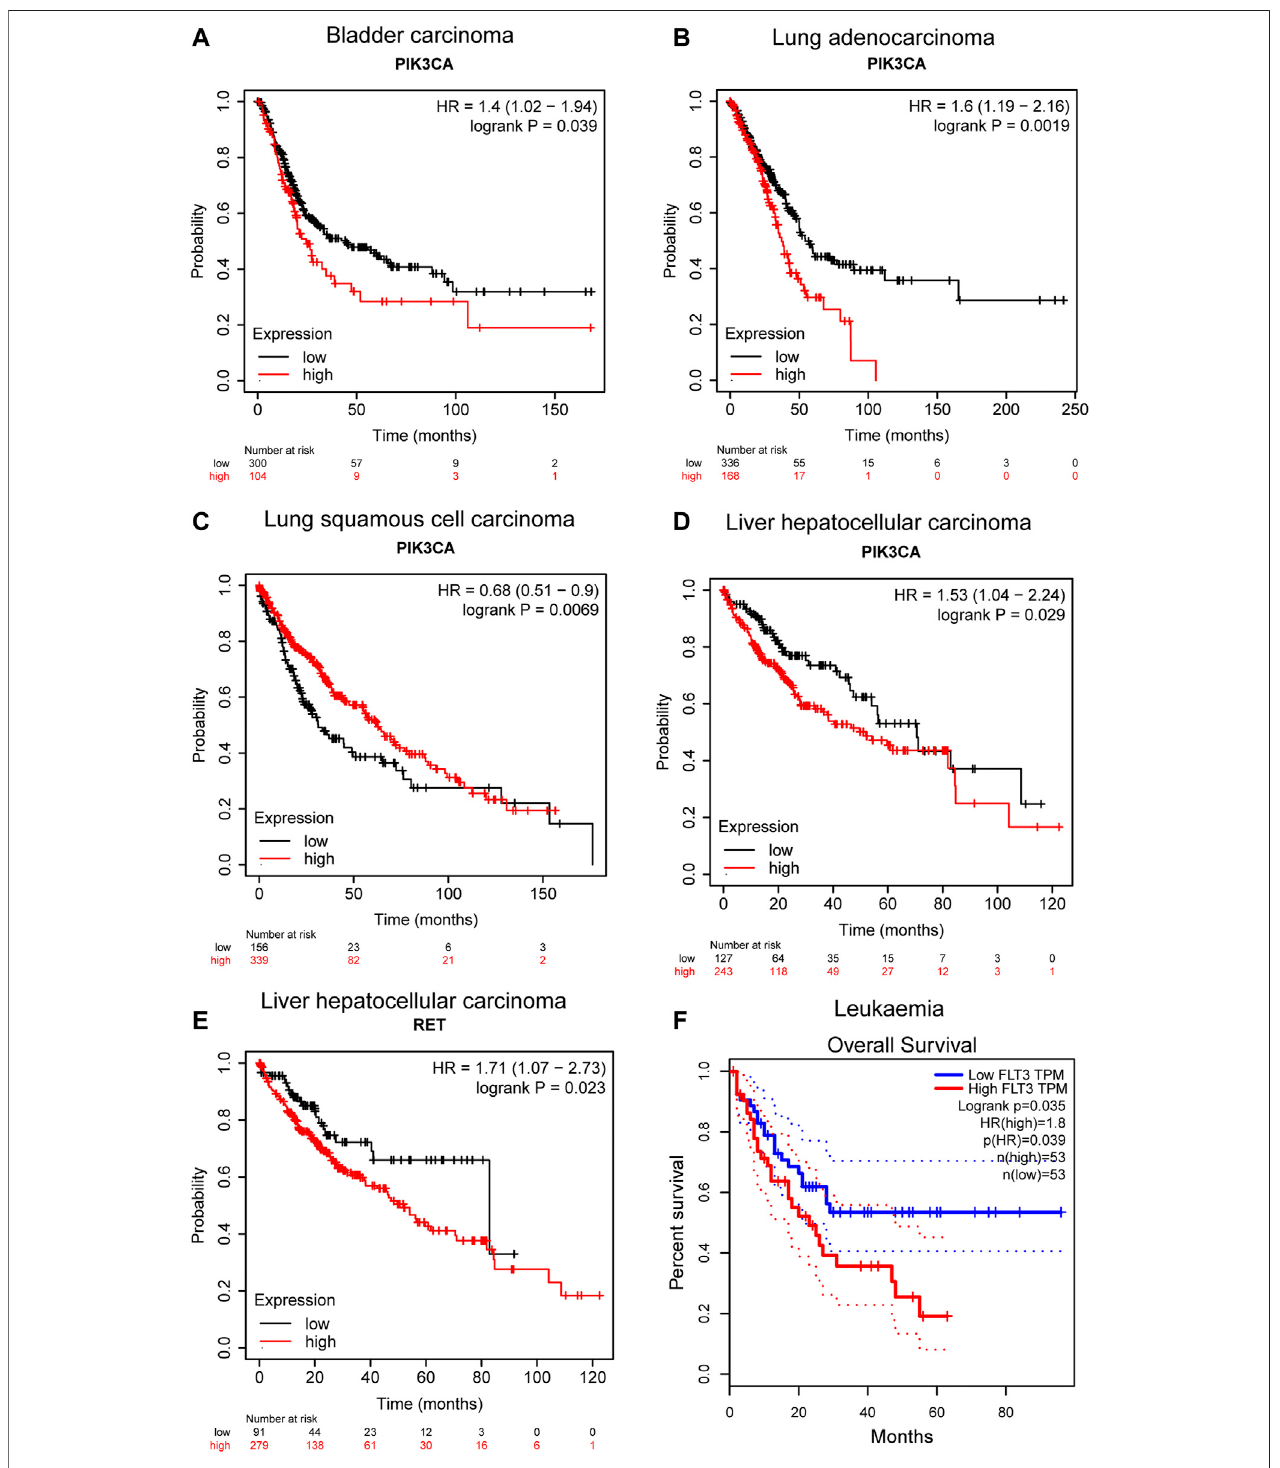
FIGURE 7 | Correlation between predicted target expression and survival prognosis of speci fi c cancers. (A – E) KM-plotter and (F) GEPIA were used to perform overall survival analyses of different cancers by corresponding gene expression.